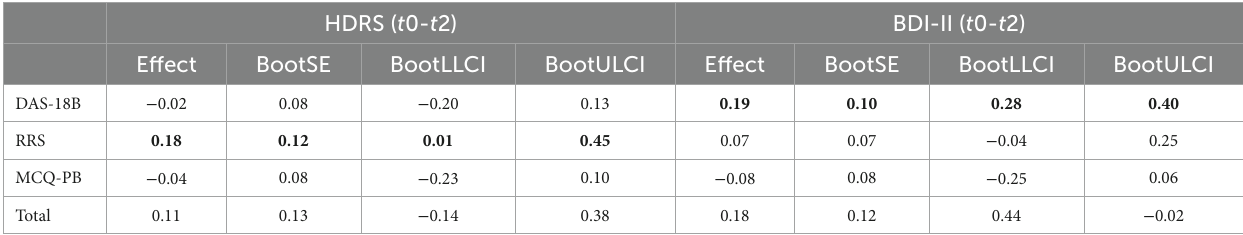
TABLE 4 Indirect effects of potential mediators on self-reported and clinician-rated